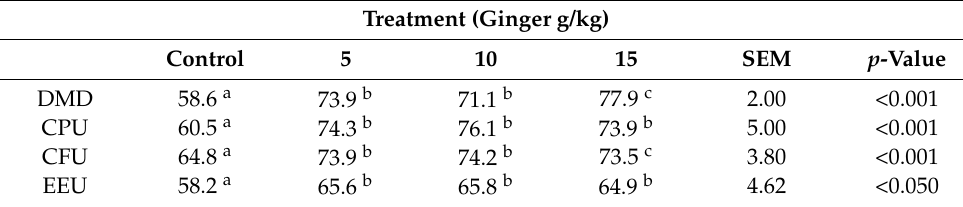
Table 3. The effects of different levels of ginger powder on nutrient utilization coefficients in broilers.